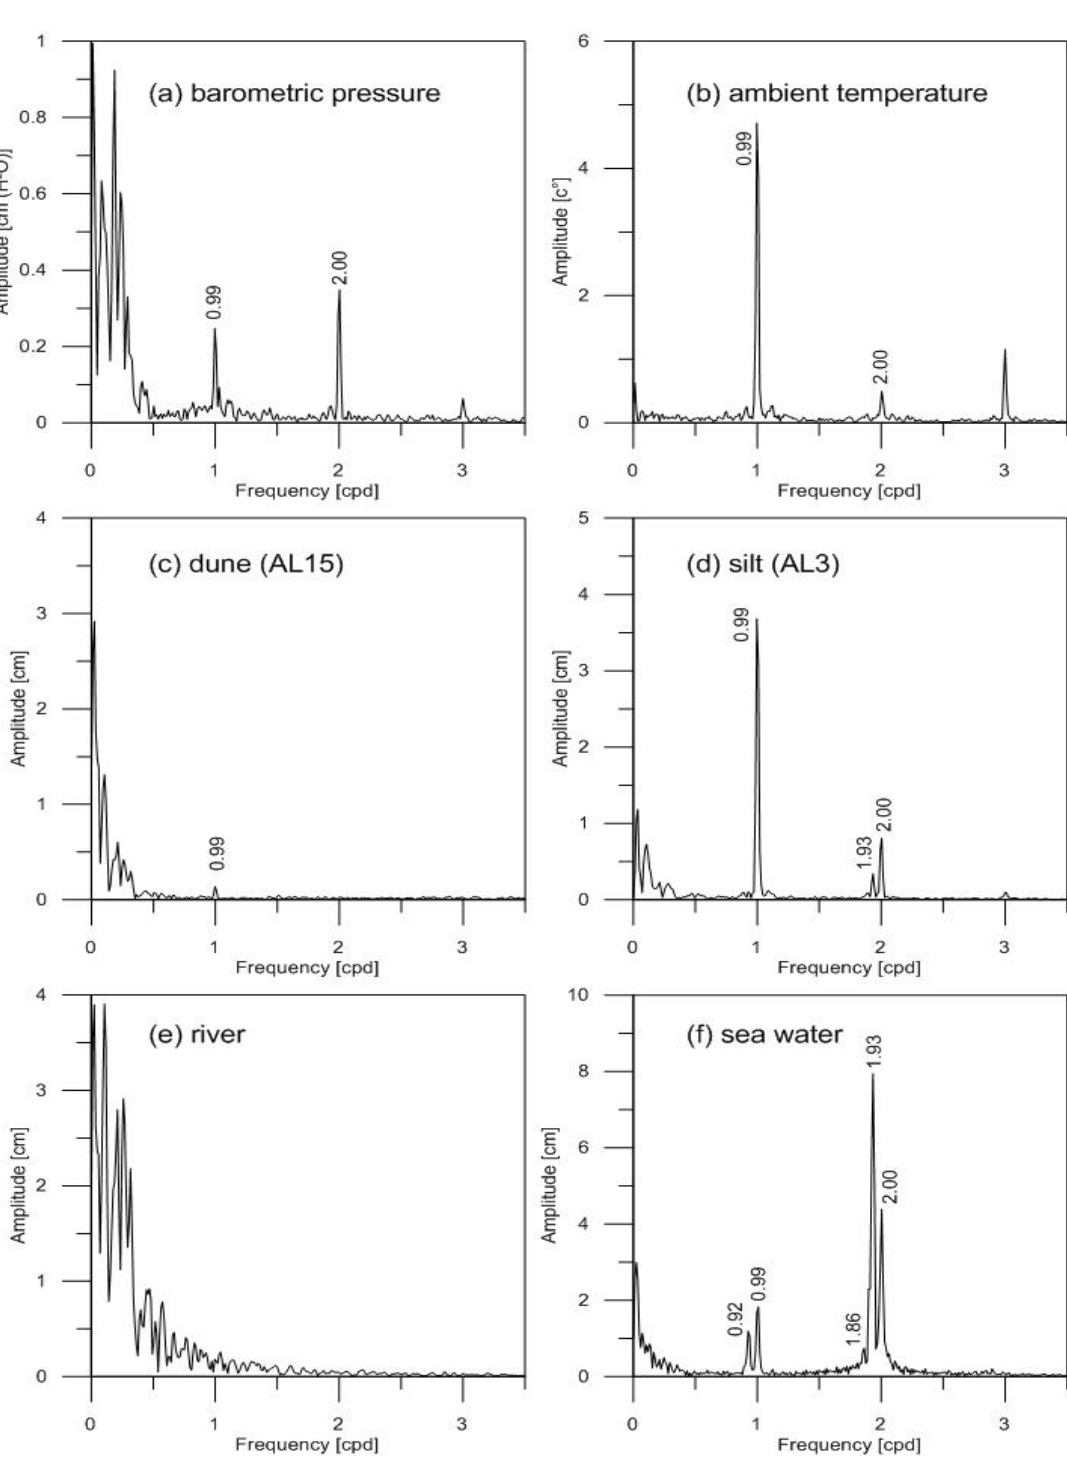
Figure 13. Fourier analysis of the May – August 2013 datasets of ( a ) barometric pressure, ( b ) relative ambient temperature, ( c ) groundwater level in the dune unit (40 m from the river), ( d ) groundwater level in the clayey silt unit (20 m from the river), ( e ) river water level, and ( f ) seawater from the Hadera Meteomarine Monitoring GLOSS station 80.